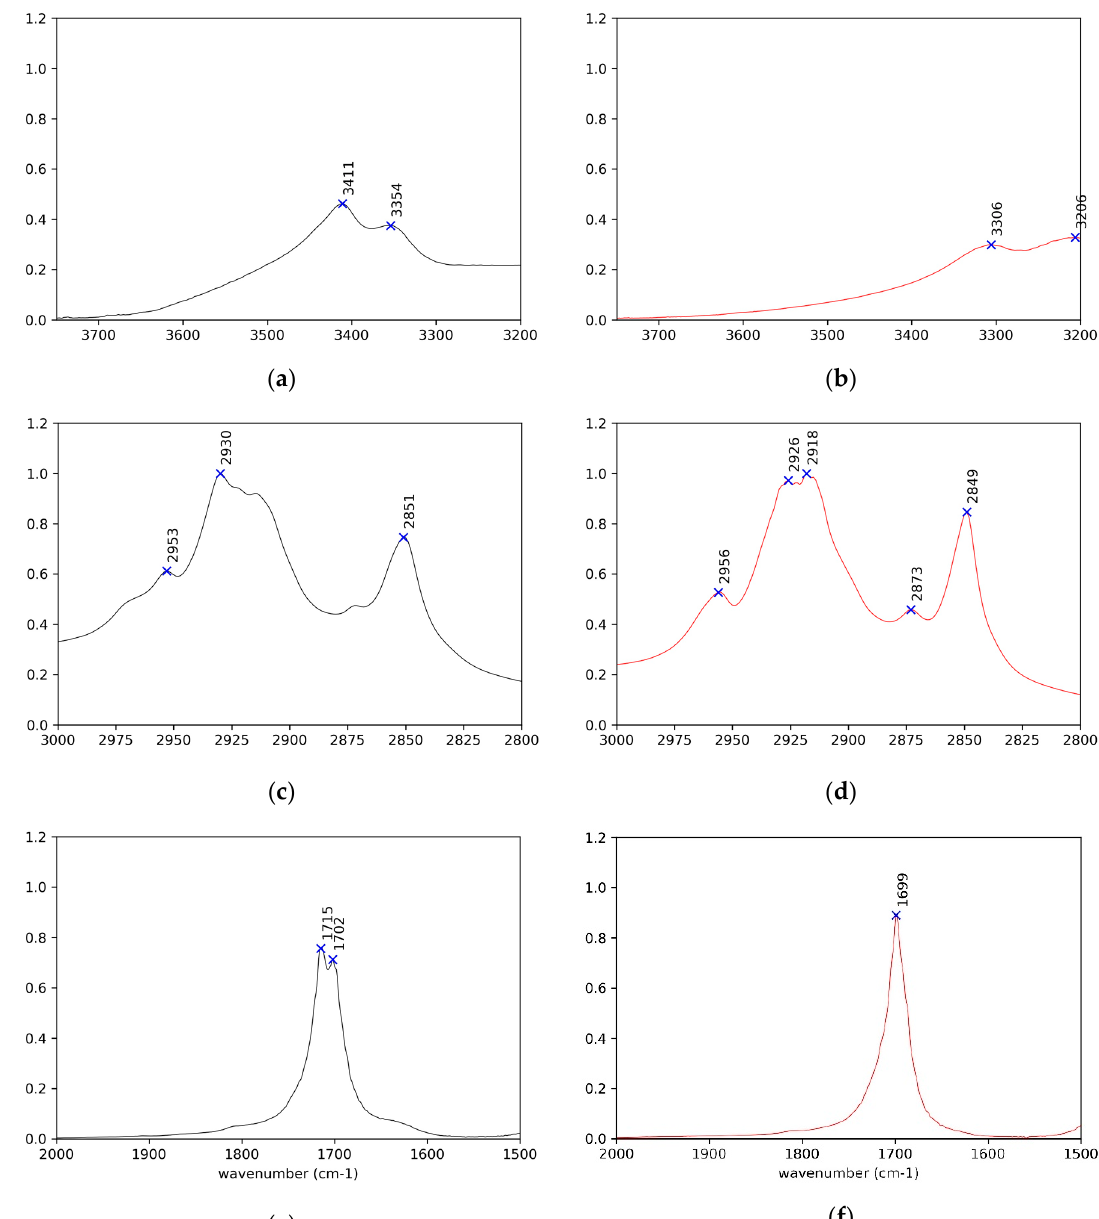
Figure 5. Enlargement of the IR spectra in the regions of OH, CH, and C = O stretching modes respectively ( a , c , e ) for ( R )-10-HSA crystals, on the left in black, and ( b , d , f ) for the heat-treated sample, on the right in red.